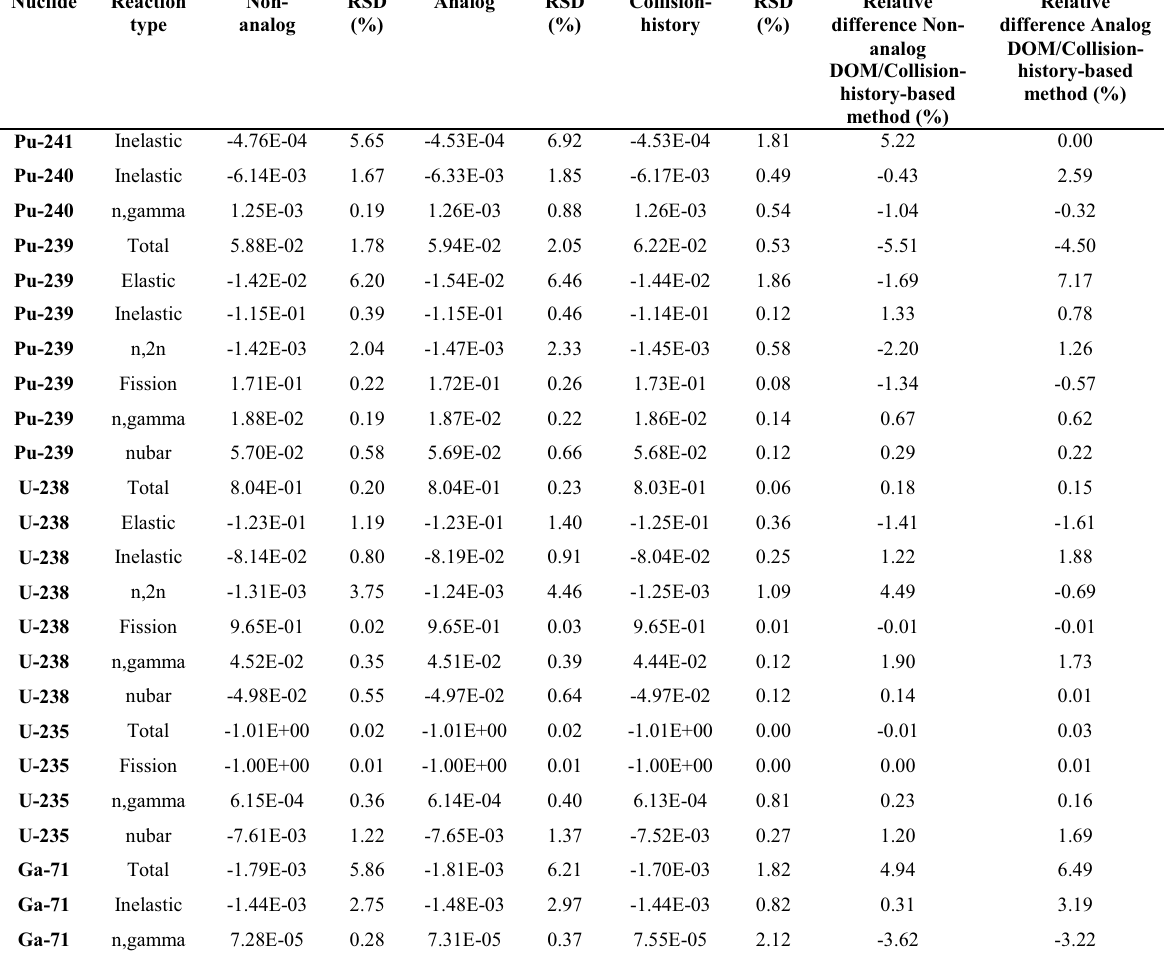
Table II. Sensitivity coefficients for the Flattop